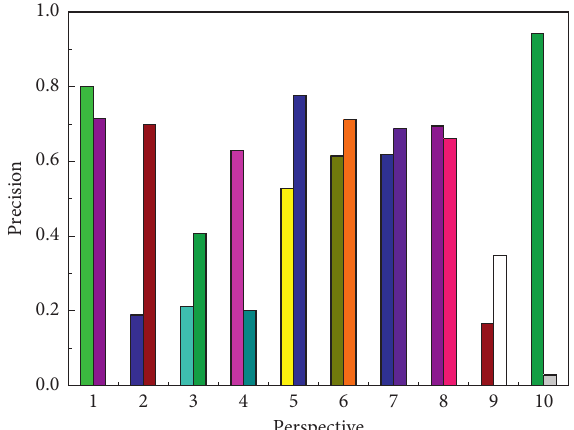
Figure 5: Accuracy of attitude estimation for two models with different perspectives.